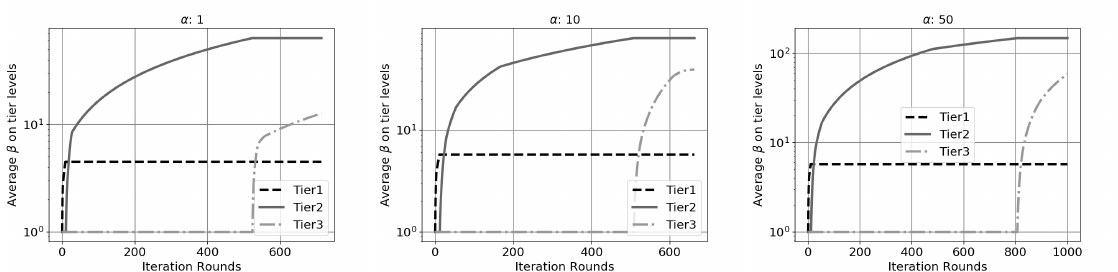
Figure 6. Middleman price β values by tier in the case of various peering cost α values in an unbalanced tree-like